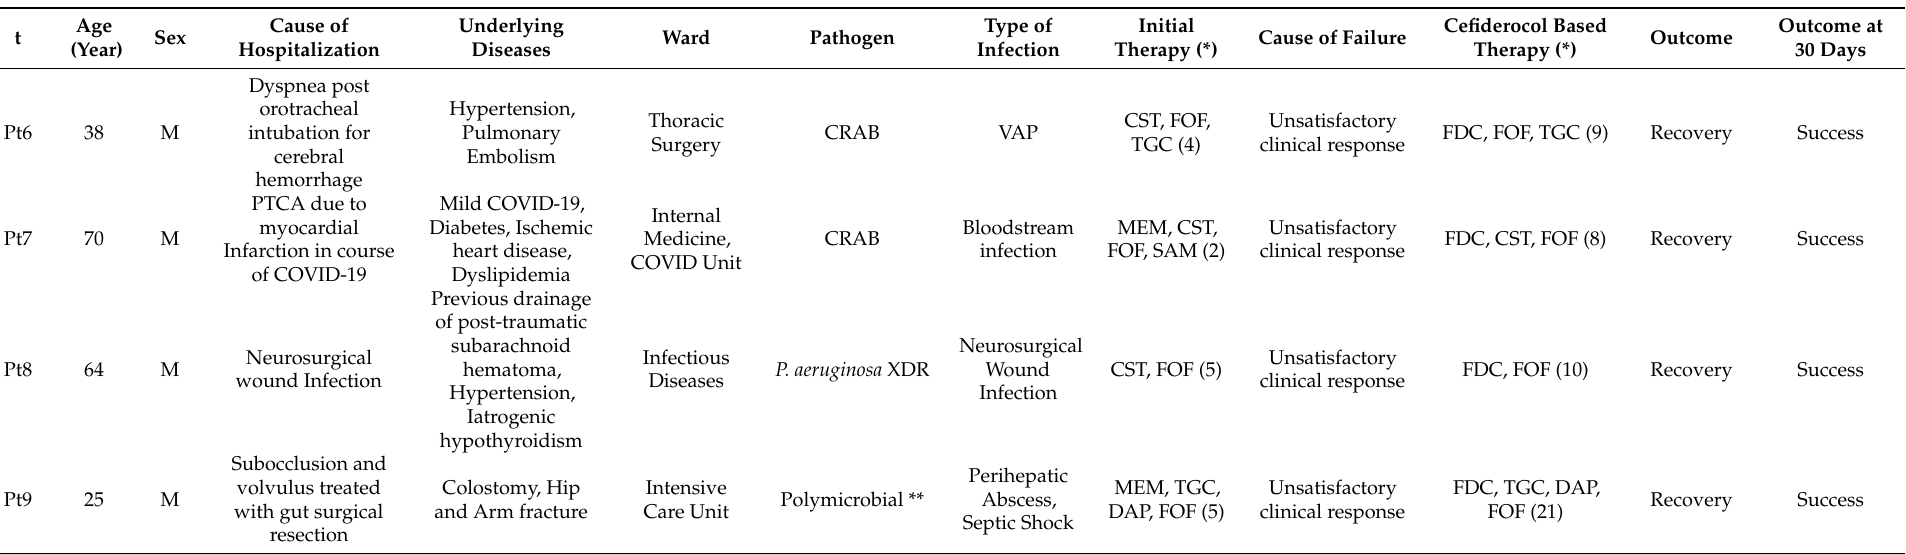
Table 2. Characteristics of patients in Group 2, with a post-surgical